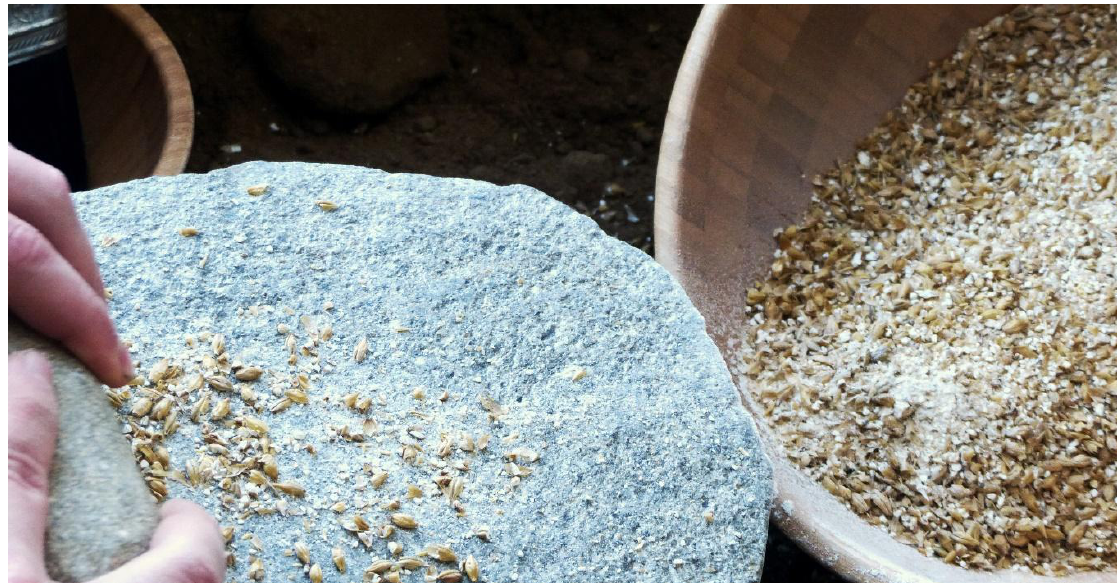
Figure 5. Experimental grinding of malt (after Valamoti 2018, ERC PLANTCULT)